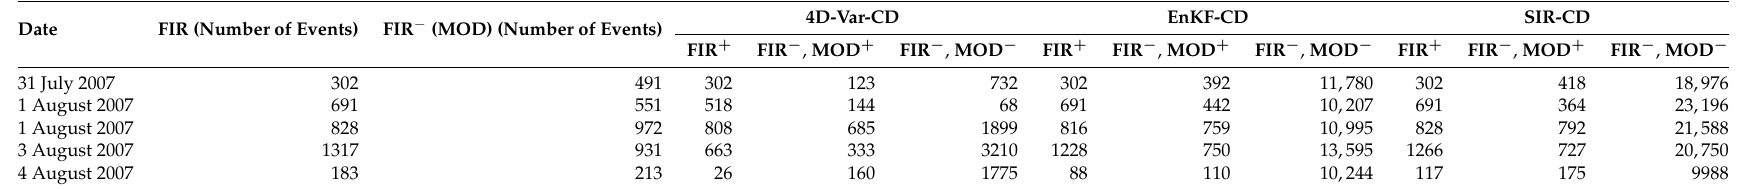
Table 4. Detection accuracy comparison against EUMETSAT FIR and MODIS MOD14/MYD14 fire products at 10 − 3.5